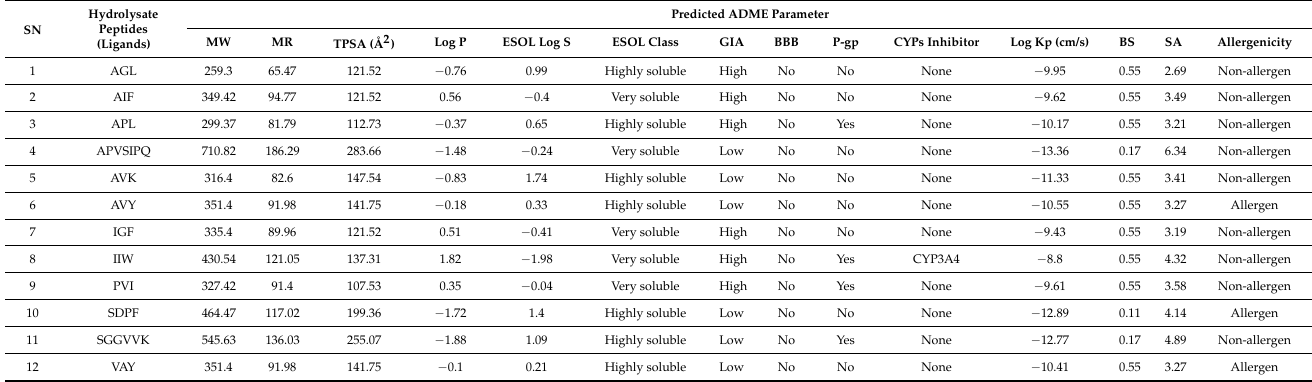
Table 2. Predicted pharmacokinetic properties of the hydrolysate